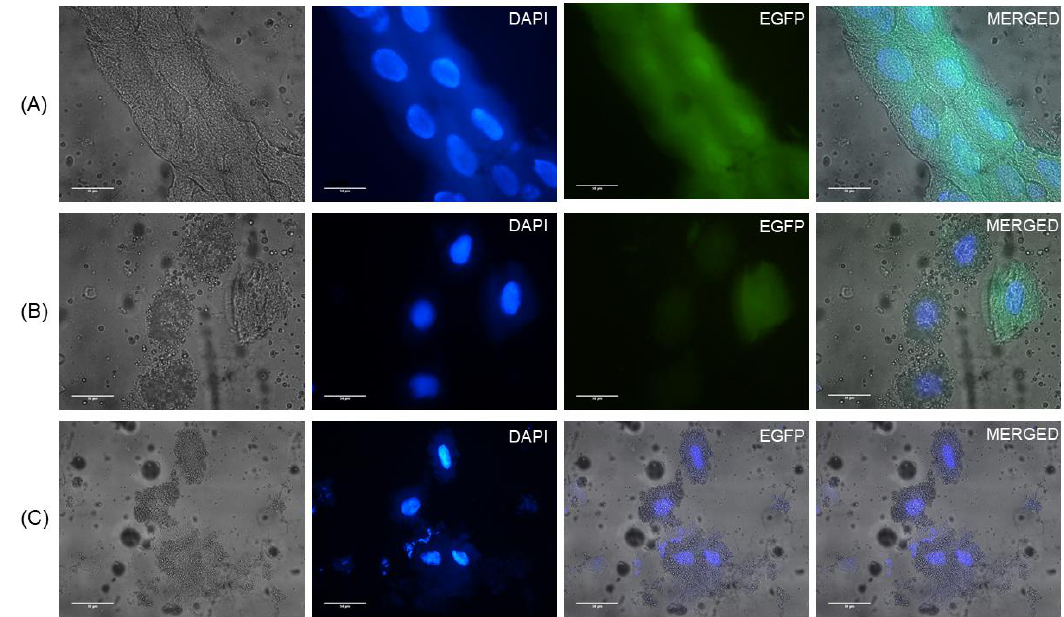
Figure 3. EGFP (green) fluorescence observation of SBV clone inoculated and control Apis cerana larvae . ( A ) Epithelial cells from an inoculated larva; ( B ) Oenocytes from an inoculated larva; ( C ) Oenocytes of a control larva. DAPI (blue) used as a counterstain. All photographs were taken under the same exposure conditions. Scale bars are 50 μm.